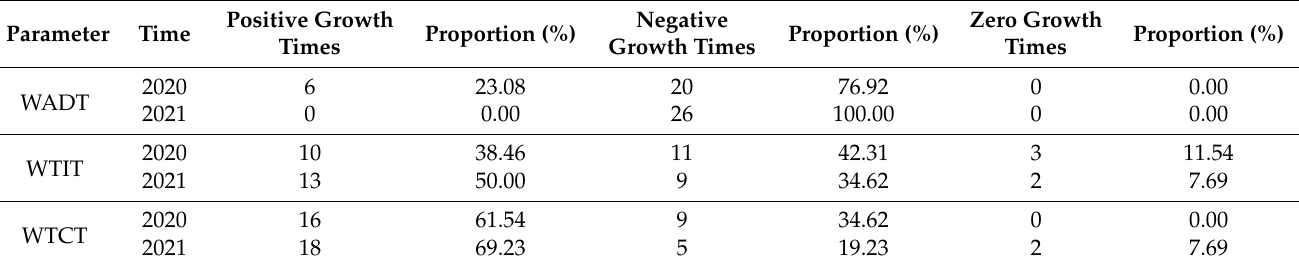
Table 4. The analysis results of the fixed base growth rate of the NPTHN service level assessment parameters.